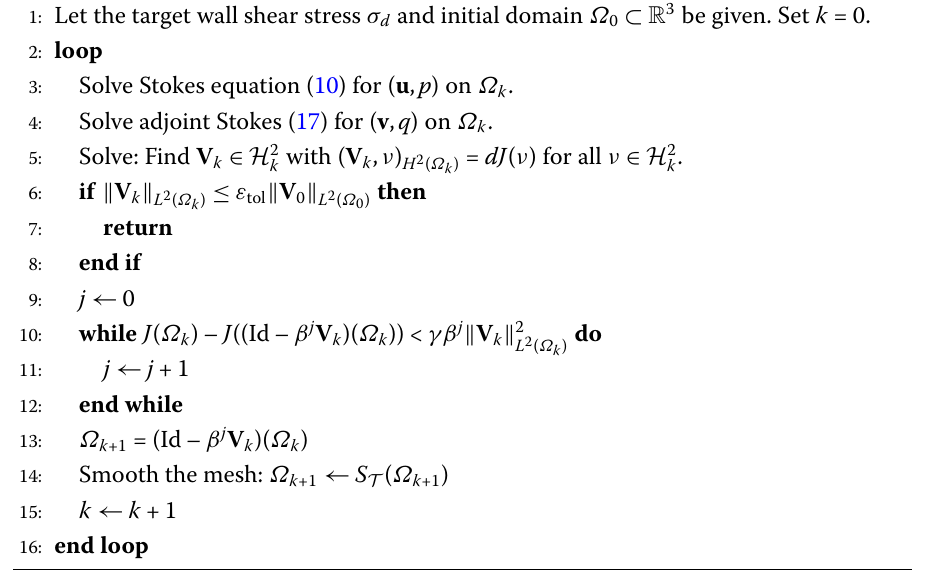
Algorithm 1 L 2 Shape Optimization